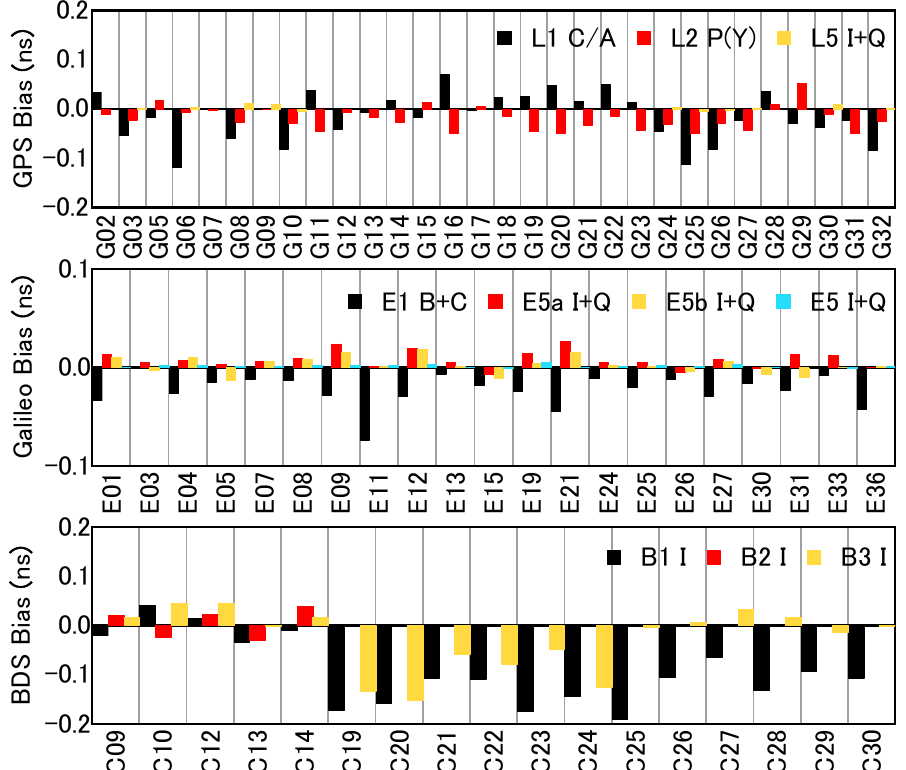
Figure 1. Receiver-related pseudorange biases of baseline ZIM2_ZIM3 for global positioning system (GPS) ( top ), Galileo ( middle ) and BeiDou navigation satellite system (BDS) ( bottom ) from day of year (DOY) 101 to 160, 2019.